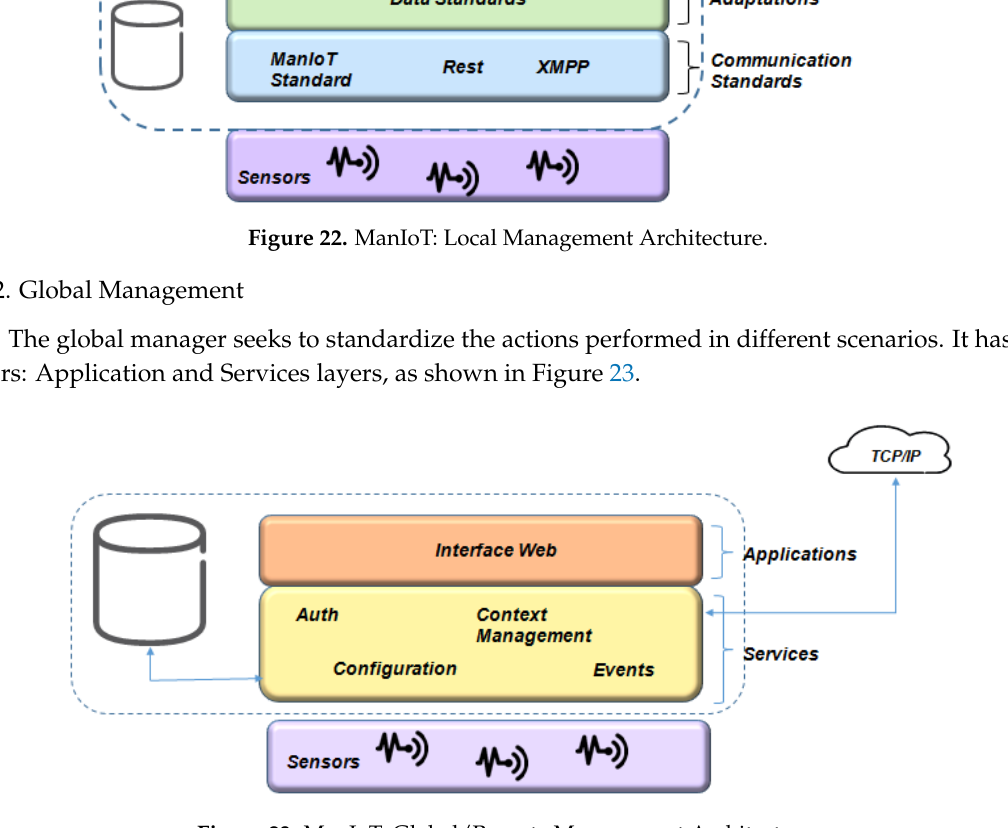
Figure 23. ManIoT: Global/Remote Management